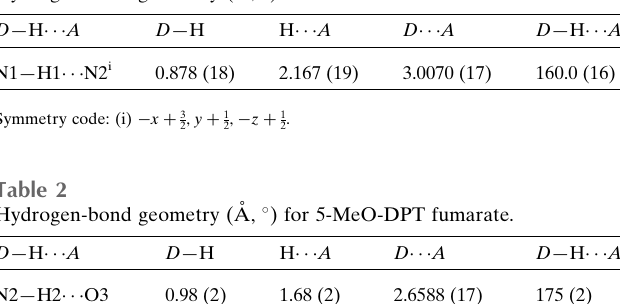
Table 1 Hydrogen-bond geometry (A˚ , (cid:4) ) for 5-MeO-DPT freebase.